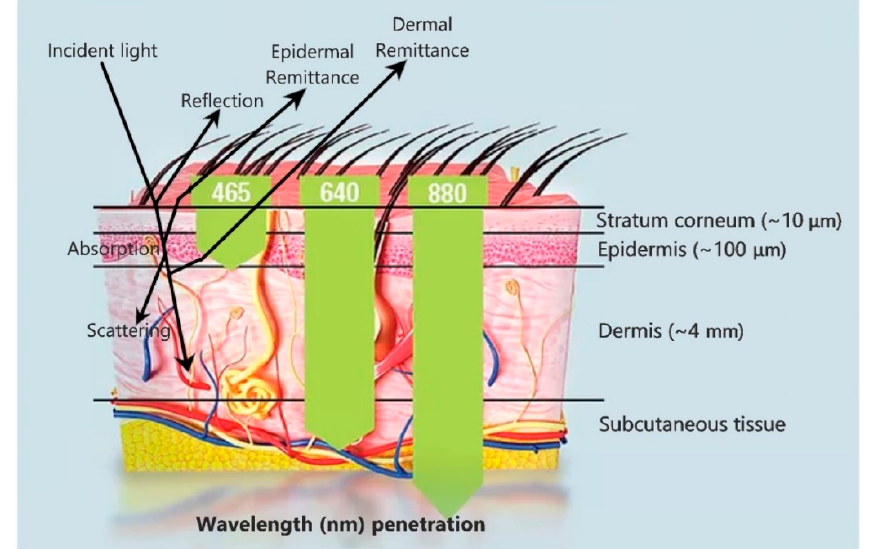
Figure 3. Incident light shows reflection, absorption, and scattering phenomena at different locations in skin layers, (Green downward pointing arrows). Light penetration into the skin with respect to its wavelength.